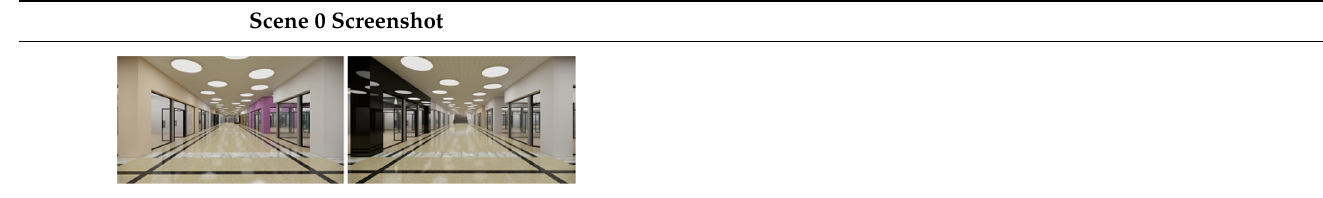
Table 5. Cont. Scene 0